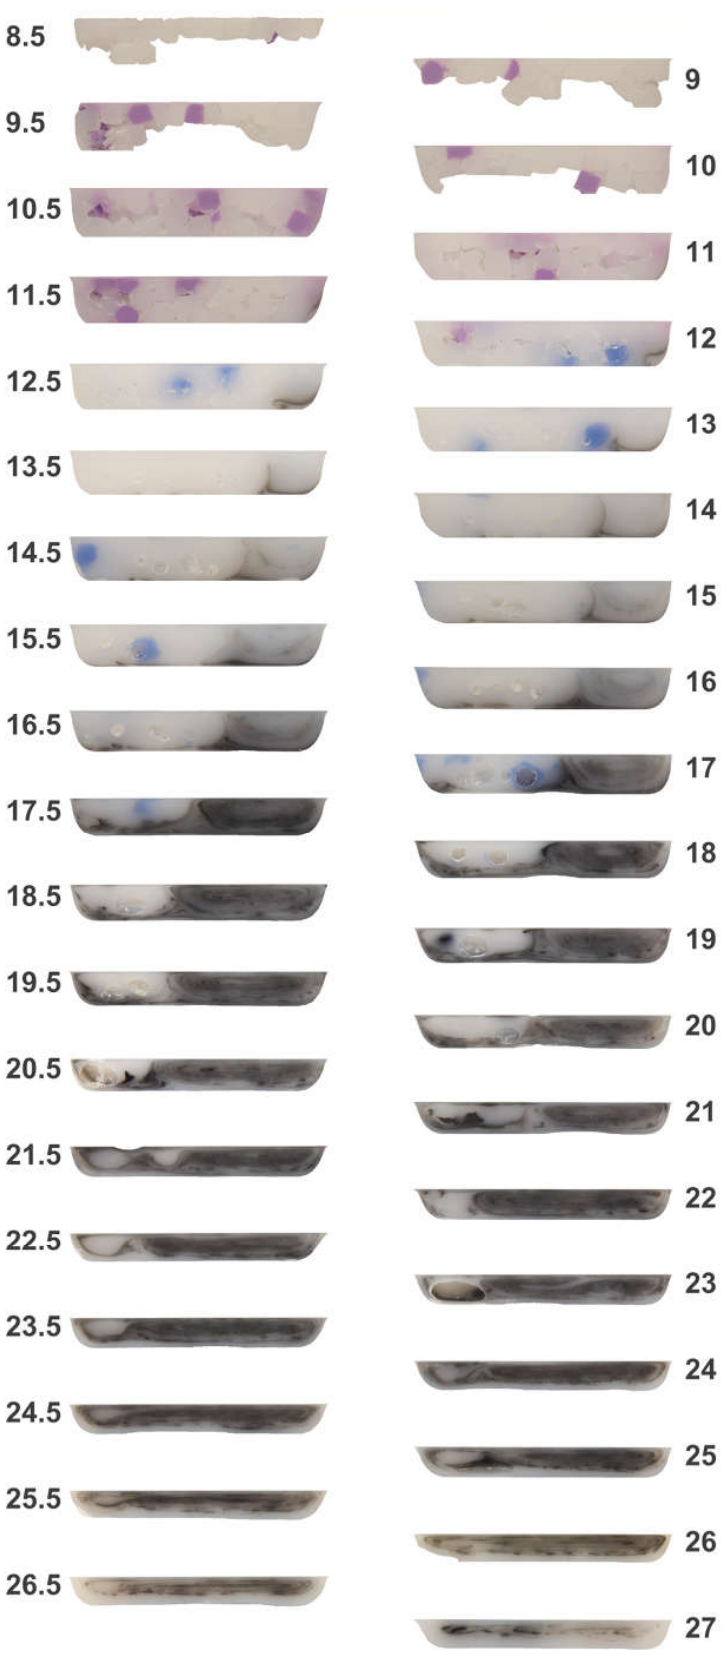
Figure 5. Sections of black, blue, and violet HIPS in the channels of the general purpose screw.